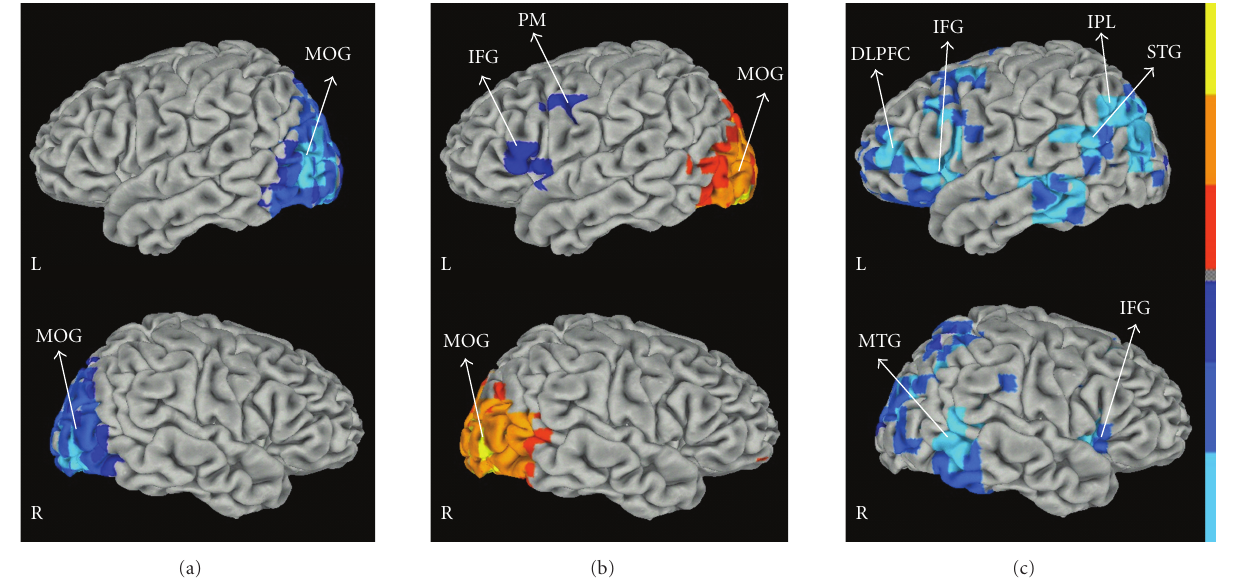
Figure 5: Group maps during the encoding, delay and retrieval epochs of the working memory task at beta frequency (14–30Hz); P < . 005 corrected. (a) The encoding epoch was associated with fairly symmetrical ERD in primary visual and visual association cortex. The map shows an epoch of 500 ms duration (from 200 ms to 700 ms after the memory set presentation). (b) The delay epoch was associated with beta ERS in bilateral visual areas and beta ERDs in left IFG and left premotor regions. The map shows an epoch of 400ms duration (from 300ms to 700 ms after the delay began). (c) The response period beta was associated with beta ERDs over a distributed network including left DLPFC, left IFG and premotor areas, right IFG, temporal and parietal regions. The map shows an epoch of 300 ms duration (from 0ms to 300 ms after the presentation of the probe. DLPFC: dorsolateral prefrontal cortex; IFG: inferior frontal gyrus; PM: premotor area; IPL: inferior parietal lobe; STG: superior temporal gyrus; MTG: middle temporal gyrus; MOG: middle occipital gyrus. Red color coding indicates task related power increase; blue color coding indicates task related power decrease. The figure shows data rendered onto a Talairach-space surface